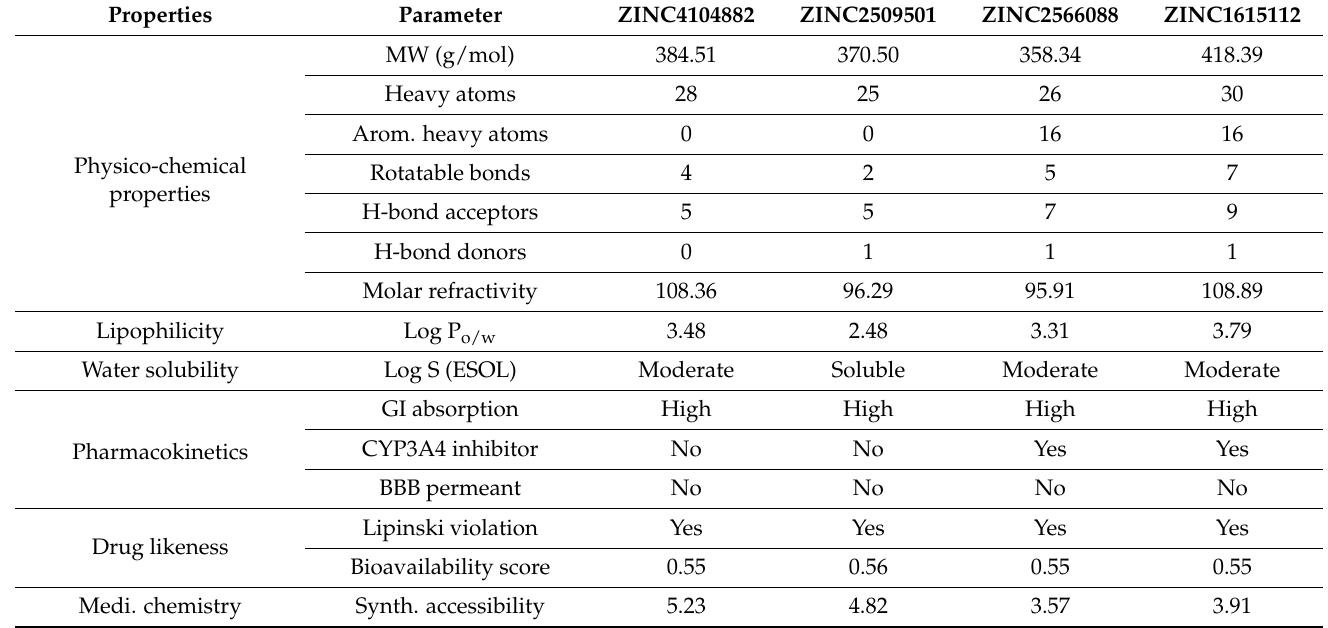
Table 3. Identification of different properties of our four selected compounds showing the different physical, chemical, pharmacokinetic, and drug-likeness properties.